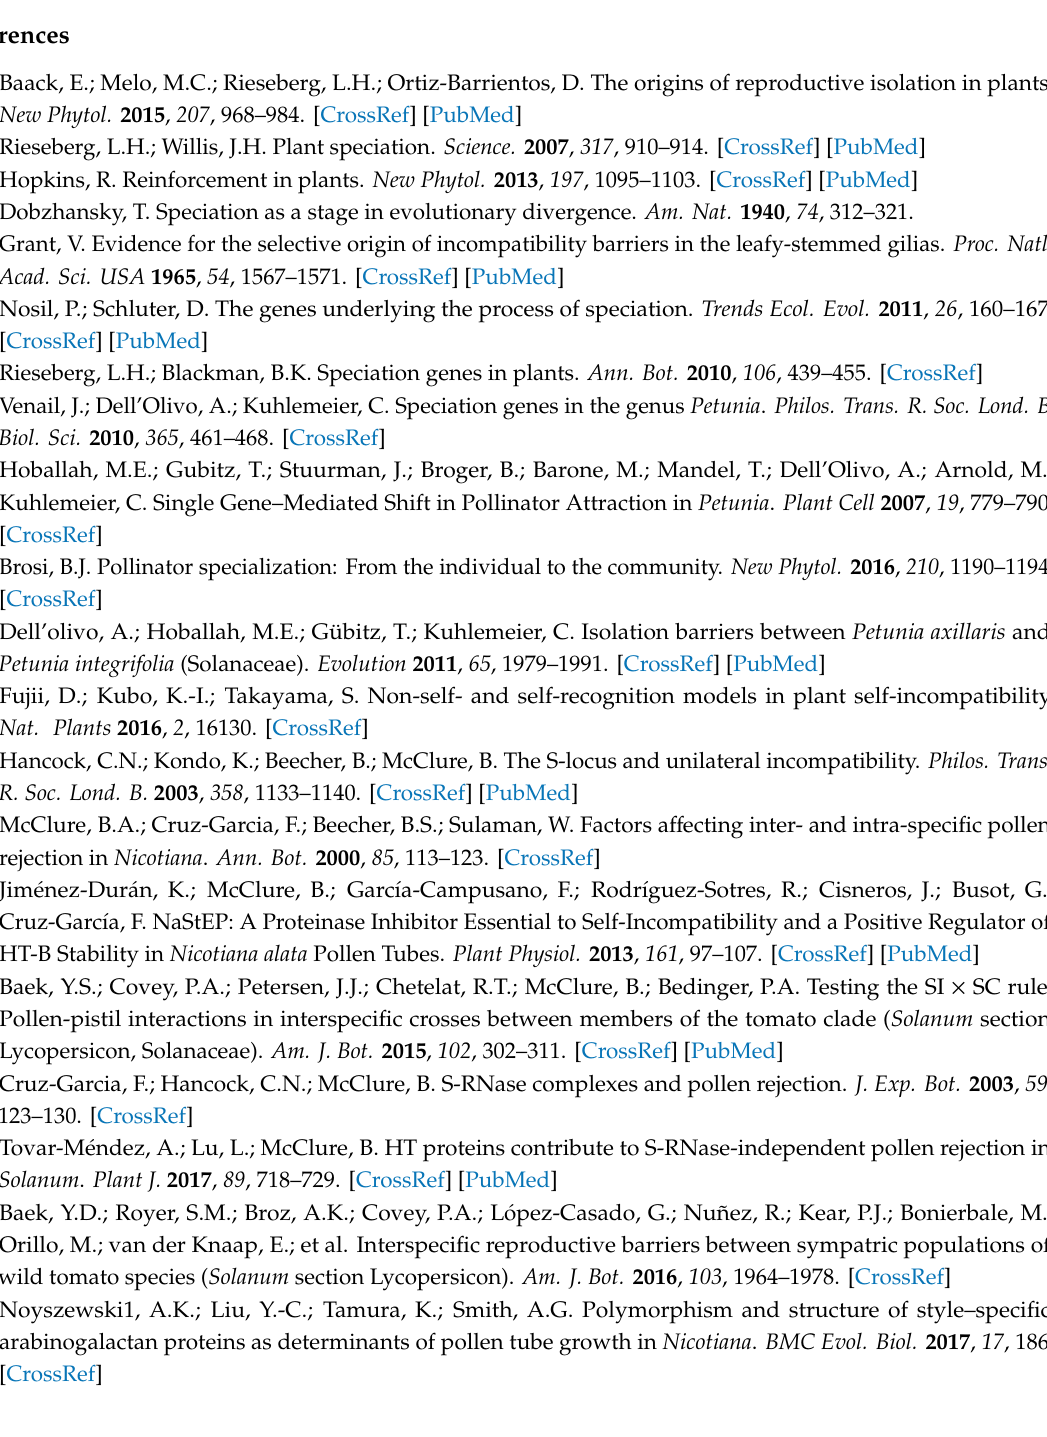
Figure S1: Multiple Alignment of HD-AGP Nucleotide Sequences, Table S1: Covariance Matrix for 15 Solanaceous HD-AGPs, Table S2: Primer